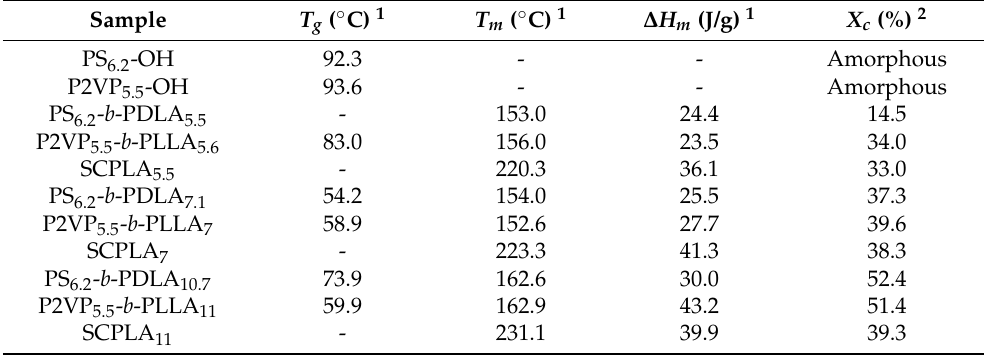
Table 2. Thermal properties of homopolymers, block copolymers, and the corresponding